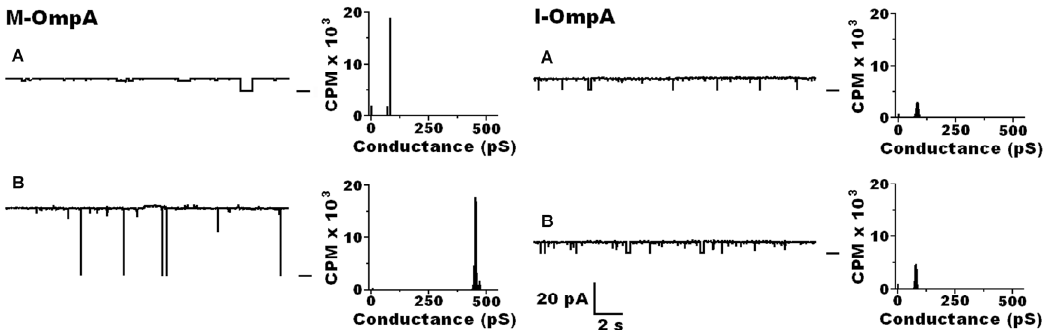
Figure 10. Representative single-channel current traces of OmpA extracted from outer membranes (M-OmpA) and OmpA extracted from inclusion bodies (I-OmpA) in E. coli BL21(DE3)pLysS cells. M-OmpA. Each protein was isolated with LDS, reconstituted in C8E4 micelles, and incorporated into bilayers of 1,2-diphytanoyl- sn -glycero-3- phosphocholine (DPhPC) between aqueous solutions of 20 mM Hepes (pH 7.4) and 1 M KCl at 22 °C. ( A ) M-OmpA and I-OmpA at 22 °C; ( B ) M-OmpA and I-OmpA at 22 °C after incubation at 40 °C for 2 h. The closed state is indicated by the bar at the right of each trace. The clamping potential was +100 mV with respect to ground (trans). The corresponding histograms from 1 min of continuous recording show the distribution of conductance magnitudes. CPM, counts per minute. From Negoda et al. FEBS 2010